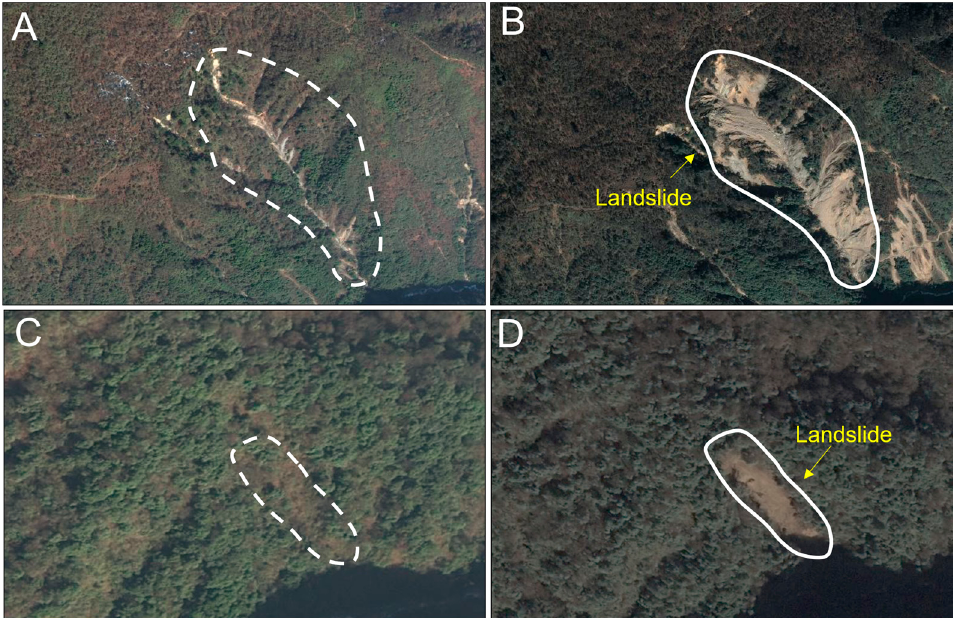
Figure 3. Coseismic landslides obtained from pre- ( A , B ) and post- ( C , D ) seismic satellite images.